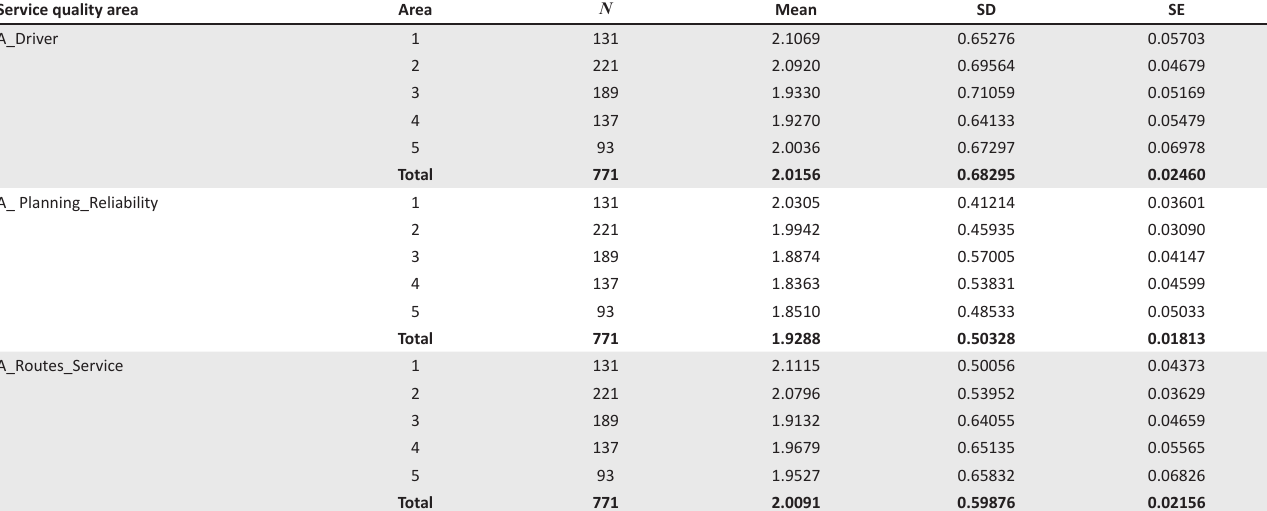
TABLE 14: Means of crowdedness and service quality areas. Service quality